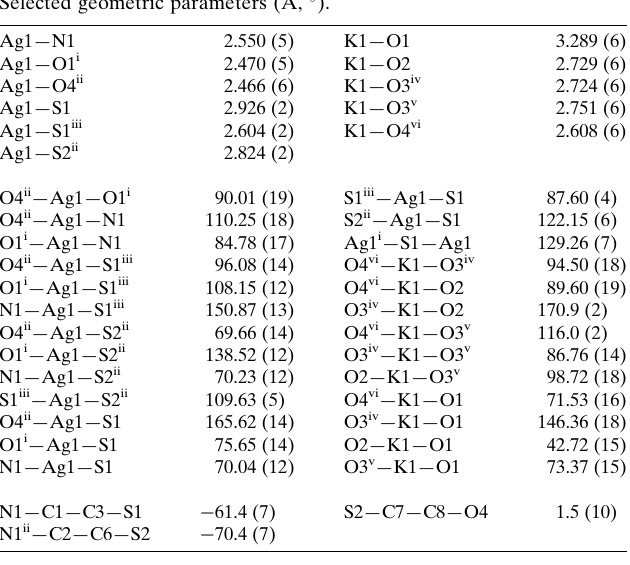
, (cid:4) z + 1 ; 2 2 , (cid:4) z + 1 2 2